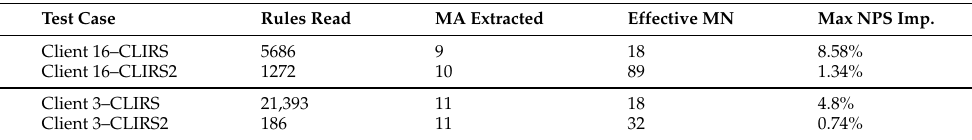
Table 3. Comparison of recommendation results in the previous (CLIRS) and the text-based approach (CLIRS2) for Clients 16 and